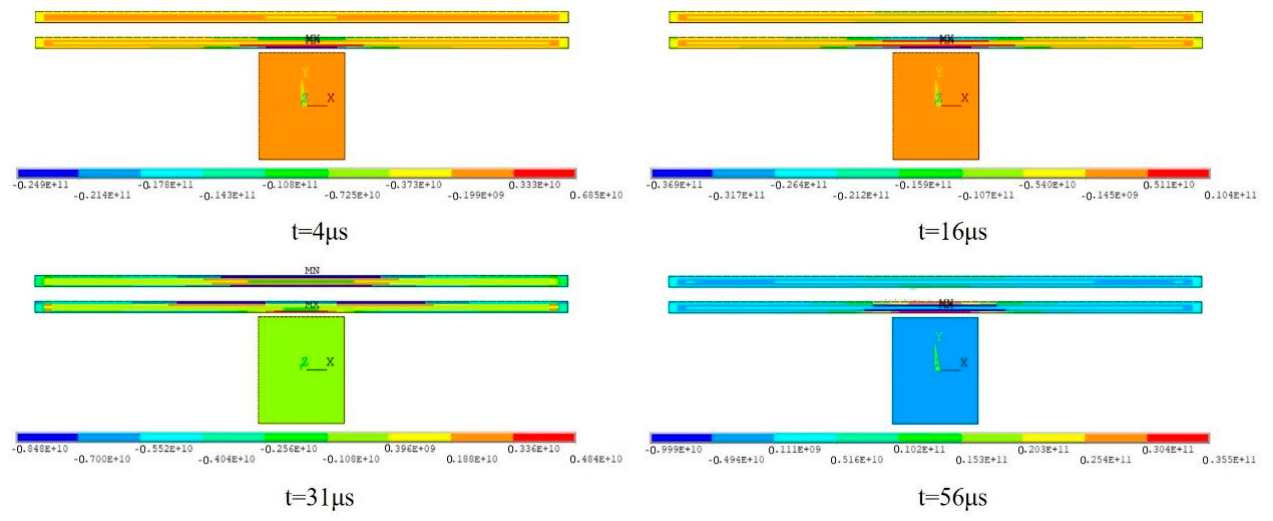
Figure 13. Induced current distribution at typical time.